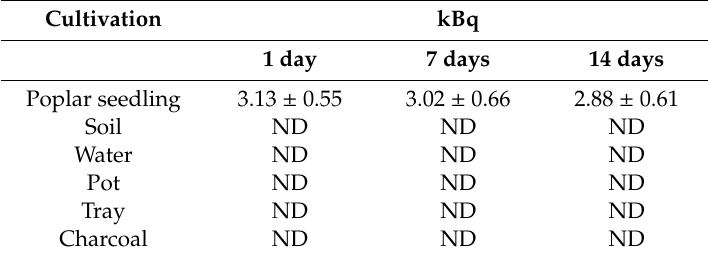
Table 3. Distribution of radioiodine during 14 days of cultivation in a sealed glass case after a 30-min exposure of one leaf of each wild-type poplar seedling to [ 125 I]I 2 gas.